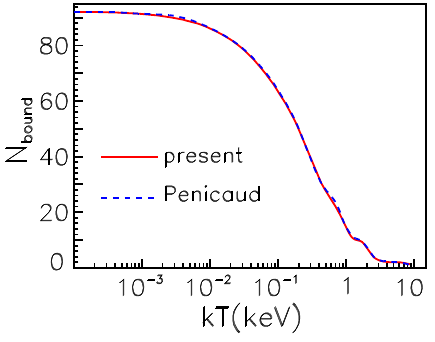
( k T ) for the uranium ion. Red bound β